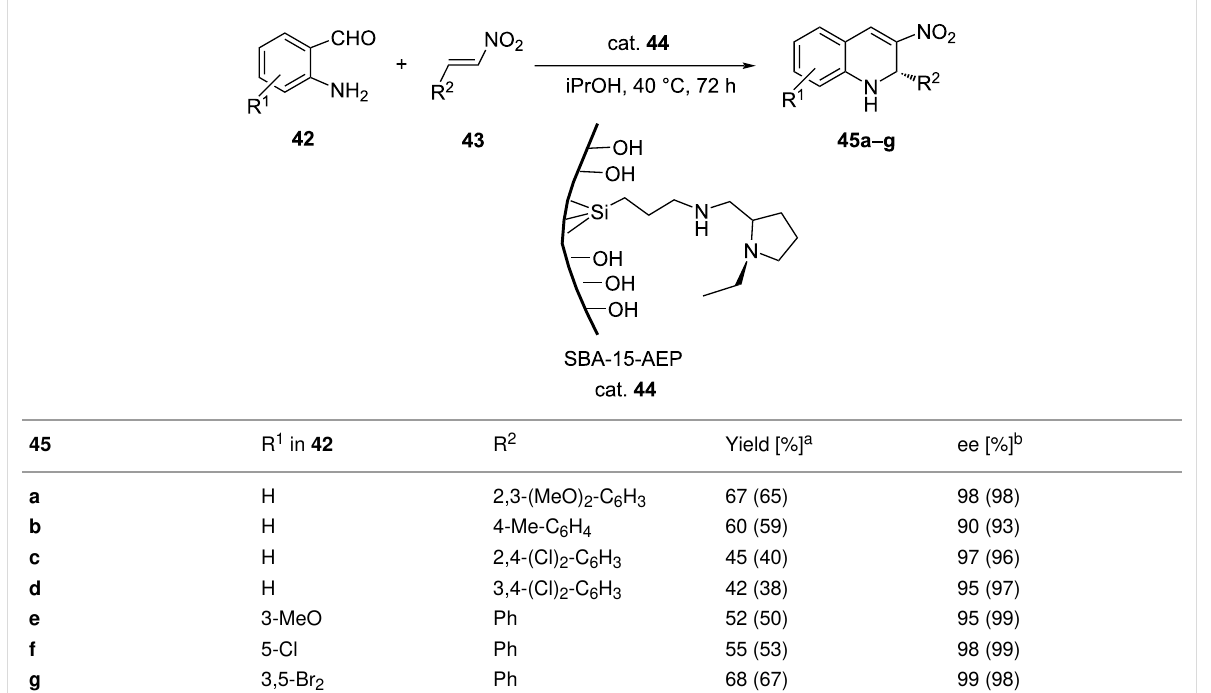
Table 9: Asymmetric aza-Michael–Henry cascade